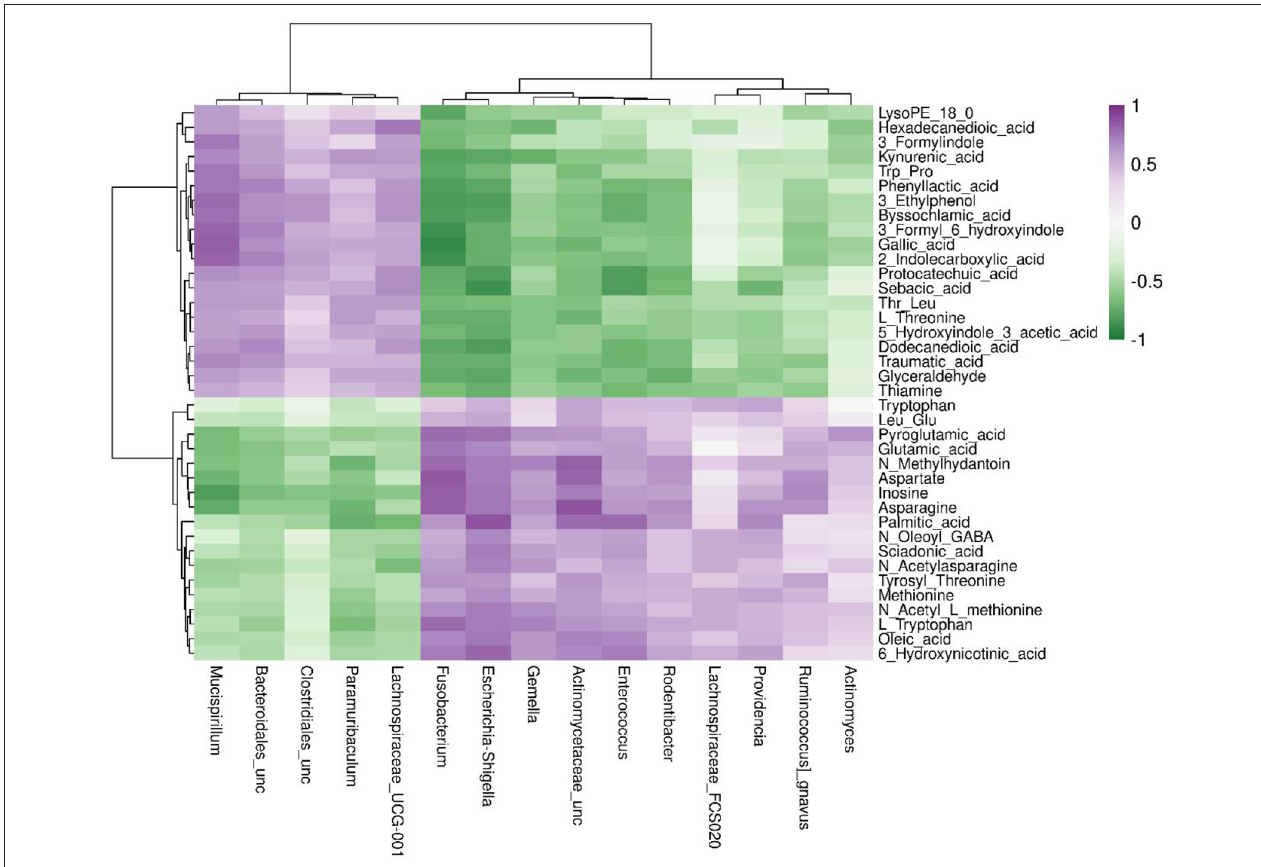
FIGURE 5 | Spearman’s correlation analysis of the metabolic products and gut microbiome in the post-A + S and baseline groups. The top 15 genera were detected using 16S rRNA data. Metabolites with fold change of > 2 between post-A + S and baseline, p < 0.05 ( t -test), and variable importance in projection (VIP) ≥ 1. The correlation effect is indicated using a color gradient from green (negative correlation) to purple (positive